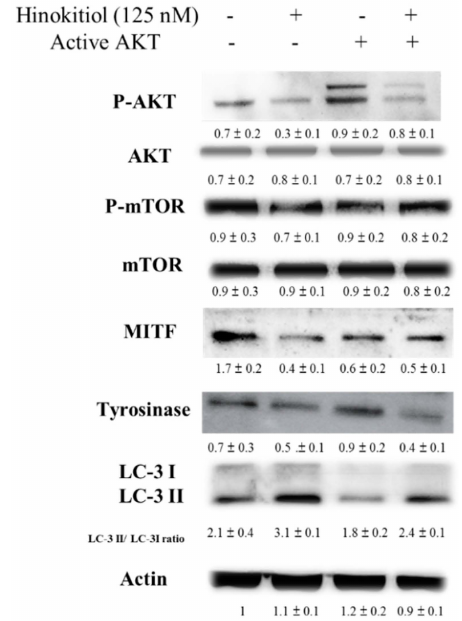
Figure 4. Constitutively active-AKT reduced the expression of tyrosinase and MITF. The B16F10 (10 5 ) cells were transfected with constitutively active AKT plasmid (5 µ g) for 16 h prior to treated with hinokitiol (125 nM) for 48 h. The expression of P-AKT, AKT, m-TOR, P-mTOR, MITF tyrosinase and LC3 protein in B16F10 cells was determined. The inserted values indicate relative protein expression compared to β -actin. This experiment was repeated with similar results. (mean ˘ SD, n = 3).